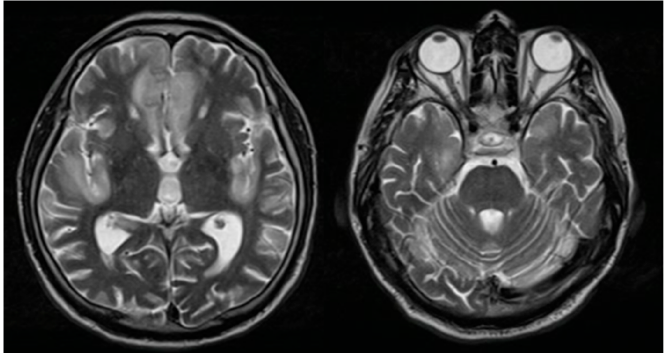
Figure 1. Brain magnetic resonance imaging: T2 sequence finding hyperintense lesions at the bilateral straight frontal gyri, left cingulate, and insula.